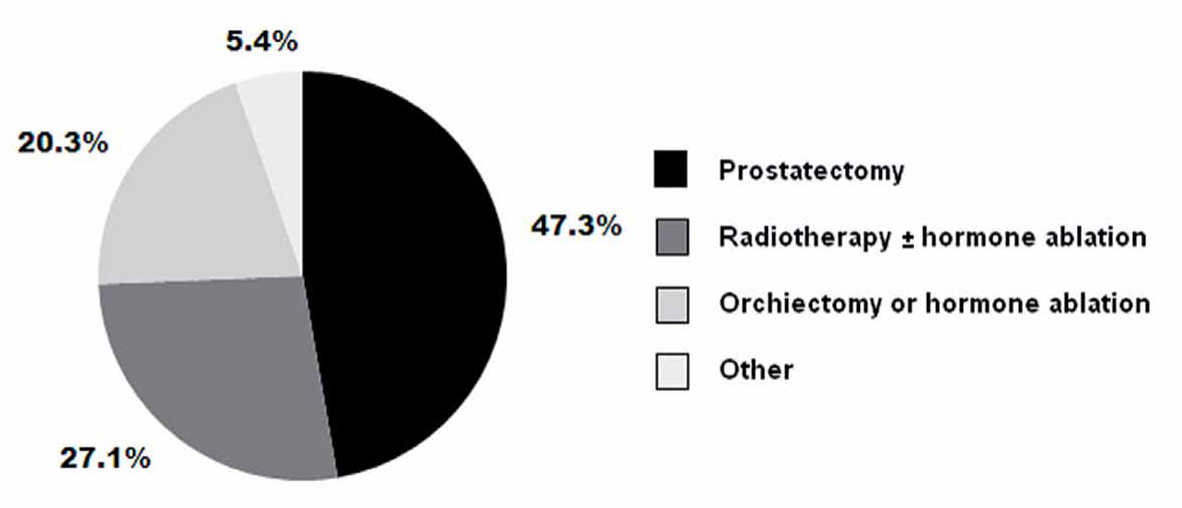
Figure 1 - Initial treatment modality recommended for patients attended at public institutions (N